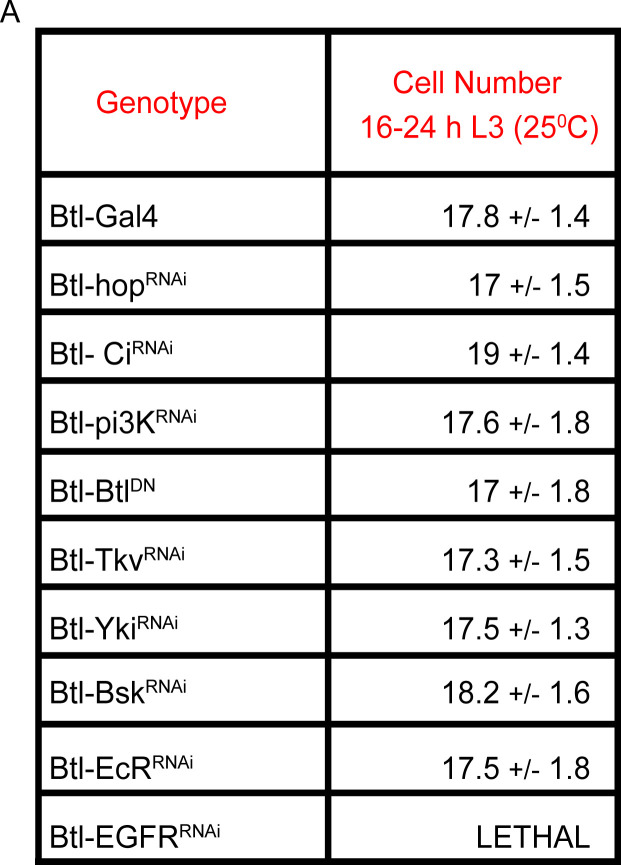
List of developmental signaling pathway knockdowns not showing proliferation at 16–24 h L3.(A) Impact of reduction of components of various developmental signaling pathways on cell numbers in Tr2 DT. Table shows cells numbers in wild type (btl-GAL4), Btl-hopRNAi (btl-GAL4/UAS-hopRNAi), Btl-CiRNAi (btl-GAL4/UAS-CiRNAi), Btl-pi3kRNAi (btl-GAL4/UAS-pi3kRNAi), Btl-BtlDN (btl-GAL4/+, UAS-BtlDN/+), Btl-TkvRNAi (btl-GAL4/UAS-TkvRNAi), Btl-YkiRNAi (btl-GAL4/+; UAS-YkiRNAi/+), Btl-BskRNAi (btl-GAL4/+; UAS-BskRNAi/+), Btl-EcRRNAi (btl-GAL4/+; UAS-EcRRNAi/+) and Btl-EGFRRNAi (btl-GAL4/+; UAS-EGFRRNAi/+) at 16–24 h L3 (mean values ± standard deviation, n ≥ 7 tracheae).